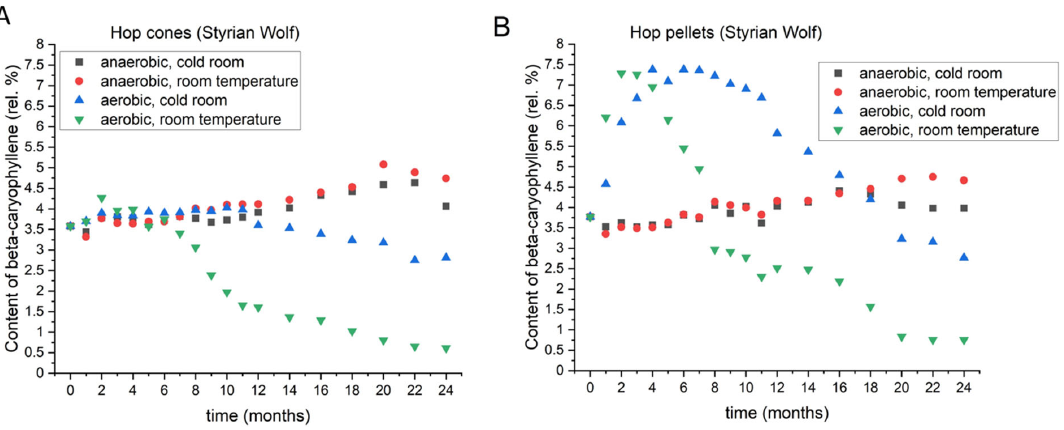
Figure 7. Changes in the content of beta-caryophyllene in Styrian Wolf cones ( A ) and pellets ( B ) during two-year period, under different storage conditions.